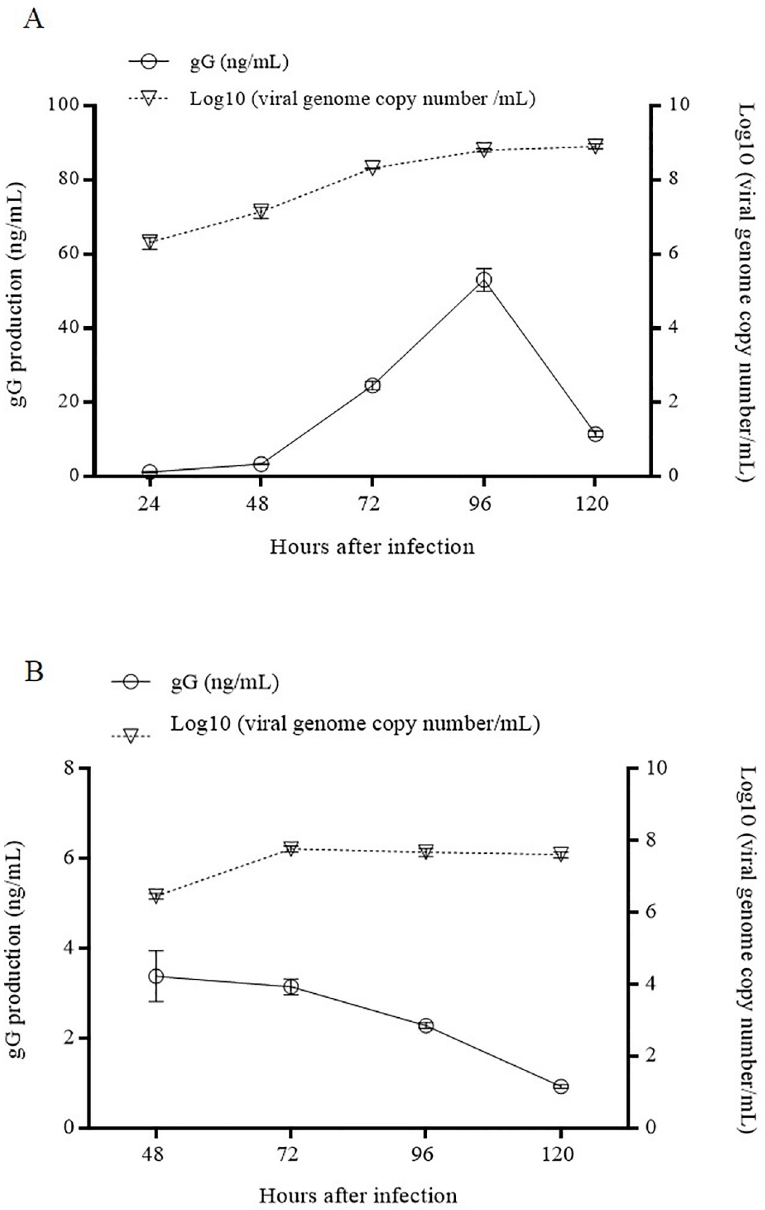
Fig 7. gG production profile in LMH cells (A) and embryonated SPF chicken eggs (B) inoculated with VFAR-043. gG production (ng/mL) was daily quantified by sandwich ELISA up to 120 hours after inoculation (Y left axis). Viral genome copy number was daily quantified by qPCR up to 120 hours after inoculation (Y right